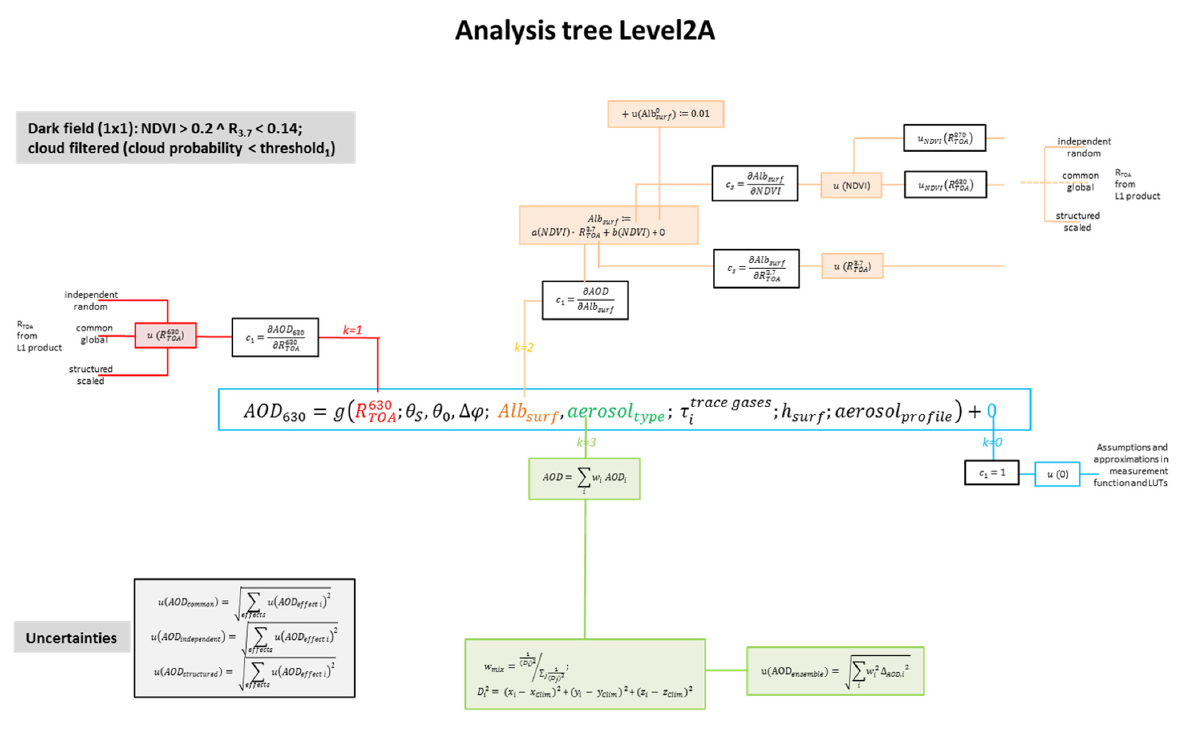
Figure 2. L2A (dark field inversion) measurement-function centered diagram.